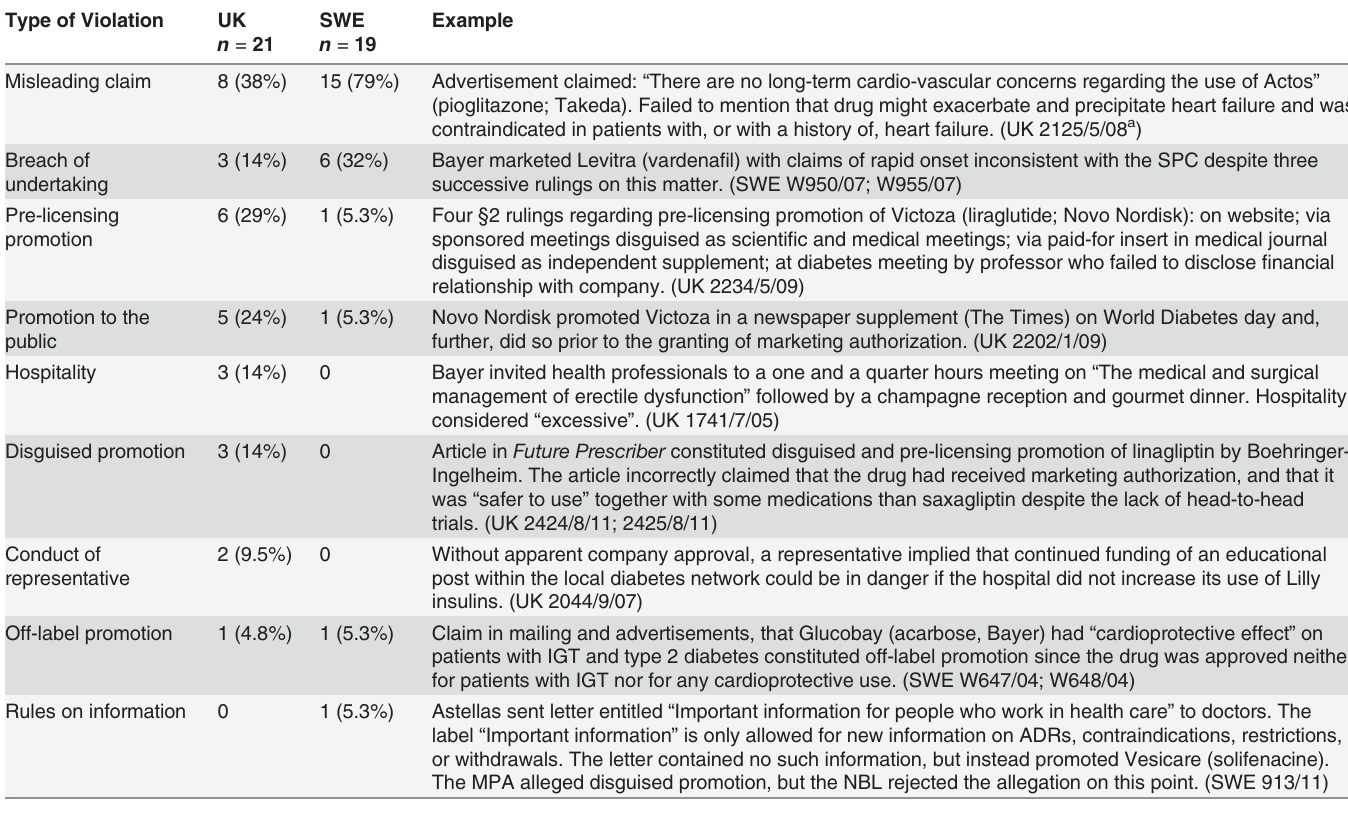
Table 5. Type and frequency of serious violation rulings: diabetes drugs and